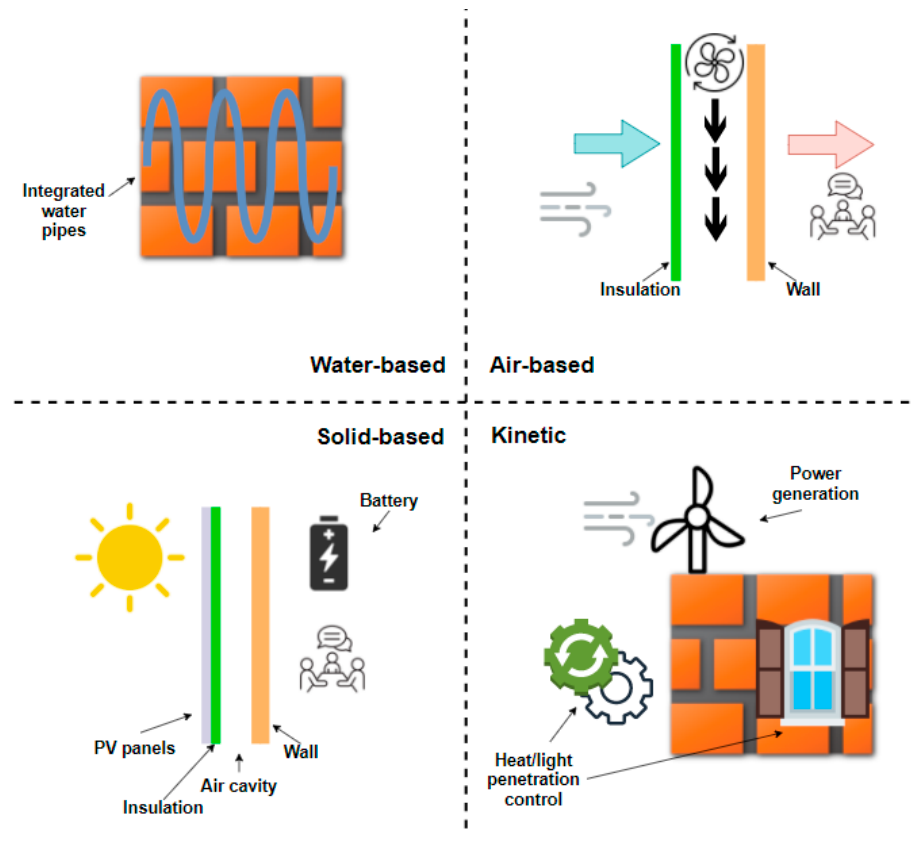
Figure 1. Typologies of ADBEs.